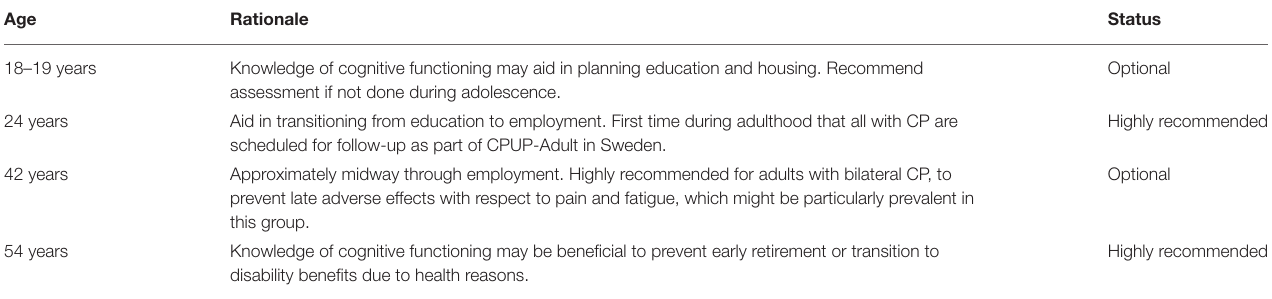
TABLE 2 | Recommended time points for the assessment of cognition and adaptive functioning in adults with cerebral